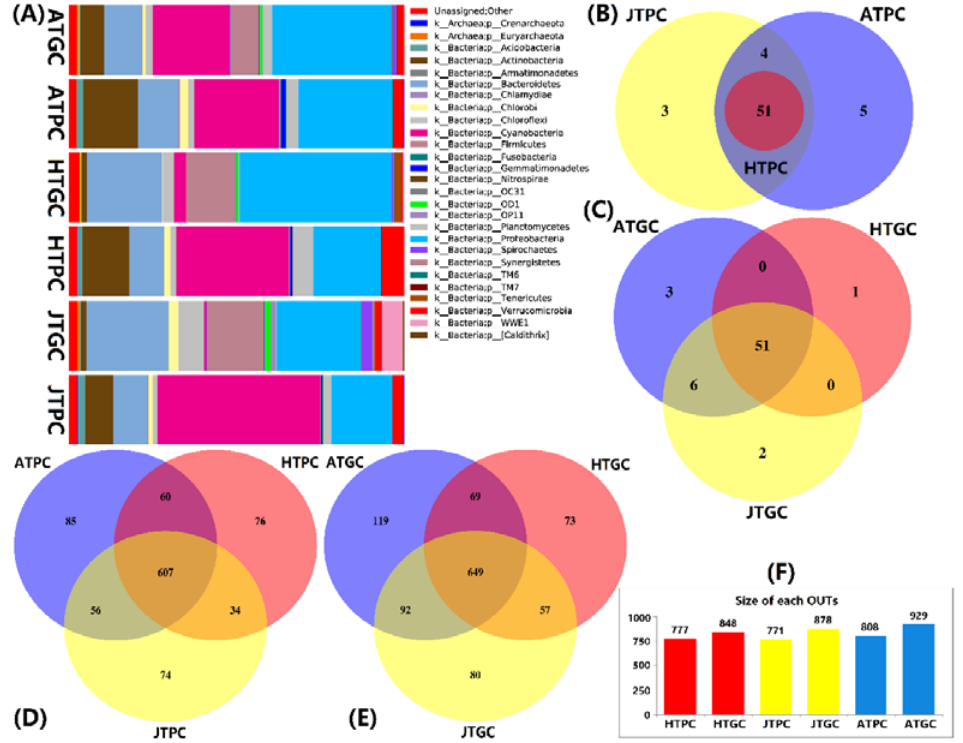
Figure 2. The bacterial community, microbiota structure and OTUs in phylum and genus levels of the pond cultivation (PC) and greenhouse cultivation (GC) groups. ( A ): microbial community structure; ( B , C ): Venn diagram of PC and GC groups in phylum level; ( D , E ): Venn diagram of PC and GC groups in genus levels; ( F ): Size of each OUTs in HTPC and HTGC, JTPC and JTGC, ATPC and ATGC.